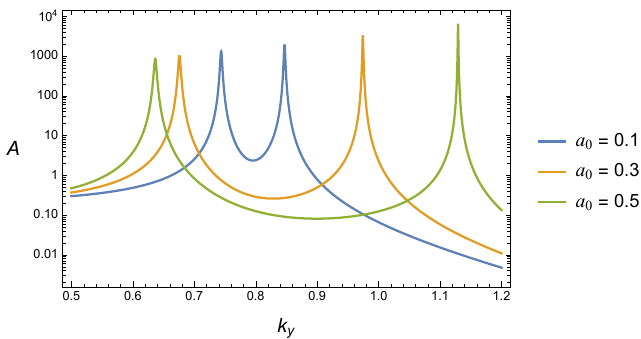
Figure 10 . The band gap with respect to the amplitude of the ionic lattice. The larger the lattice potential, the larger the gap that is observed. We choose ! = 10 (cid:0) 6 , q = 2 as well as the background geometry with T = 0 : 01426, p = 2. Note that the spike-like appearance of the peaks is due to the logarithmic